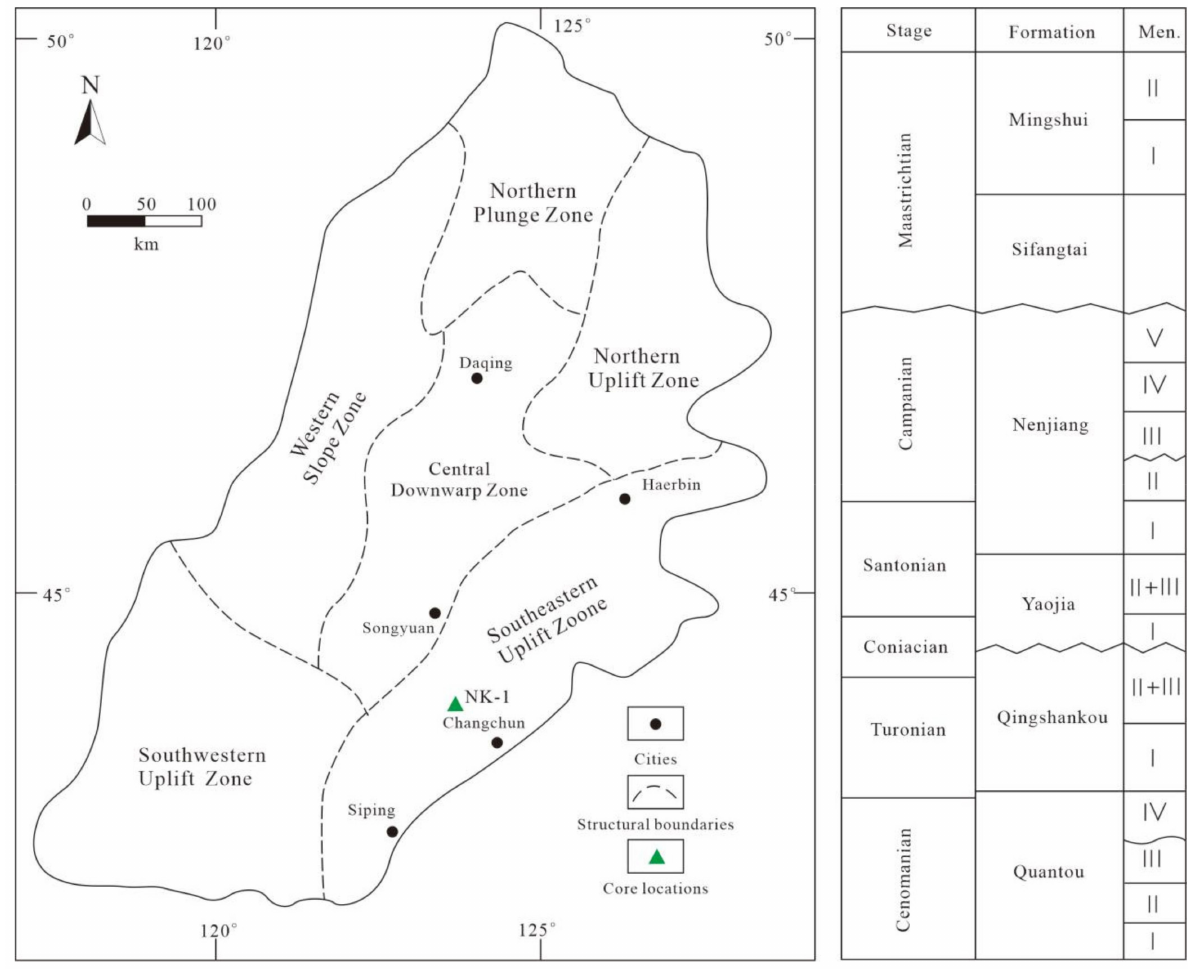
Figure 2. Geological map of the Songliao